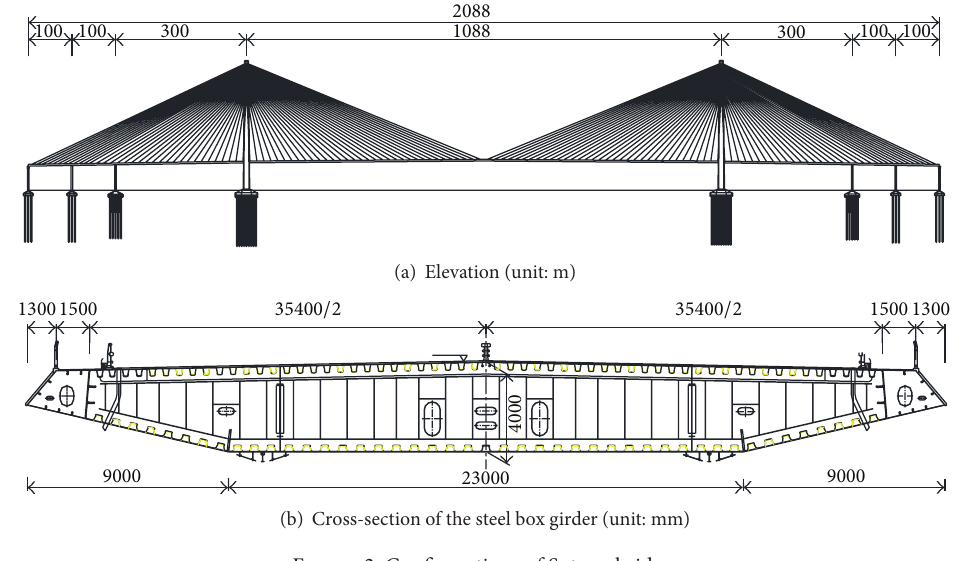
Figure 2: Configurations of Sutong bridge.